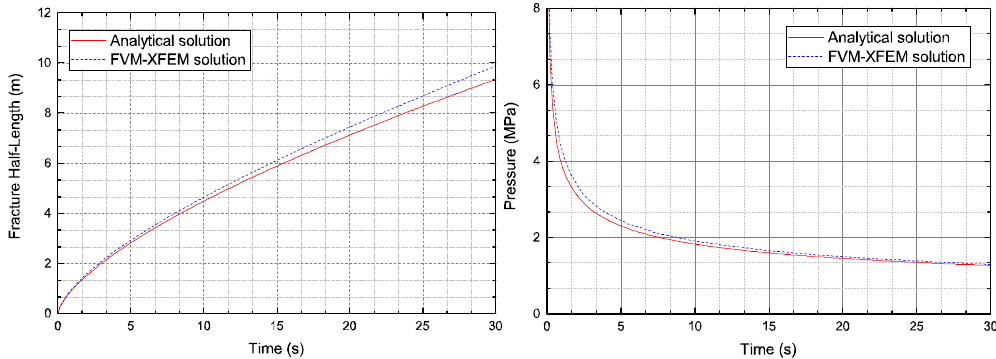
Figure 9. Comparison of the numerical and analytical solutions regarding: ( left ) the fracture half- length and ( right ) the fracture mouth pressure.